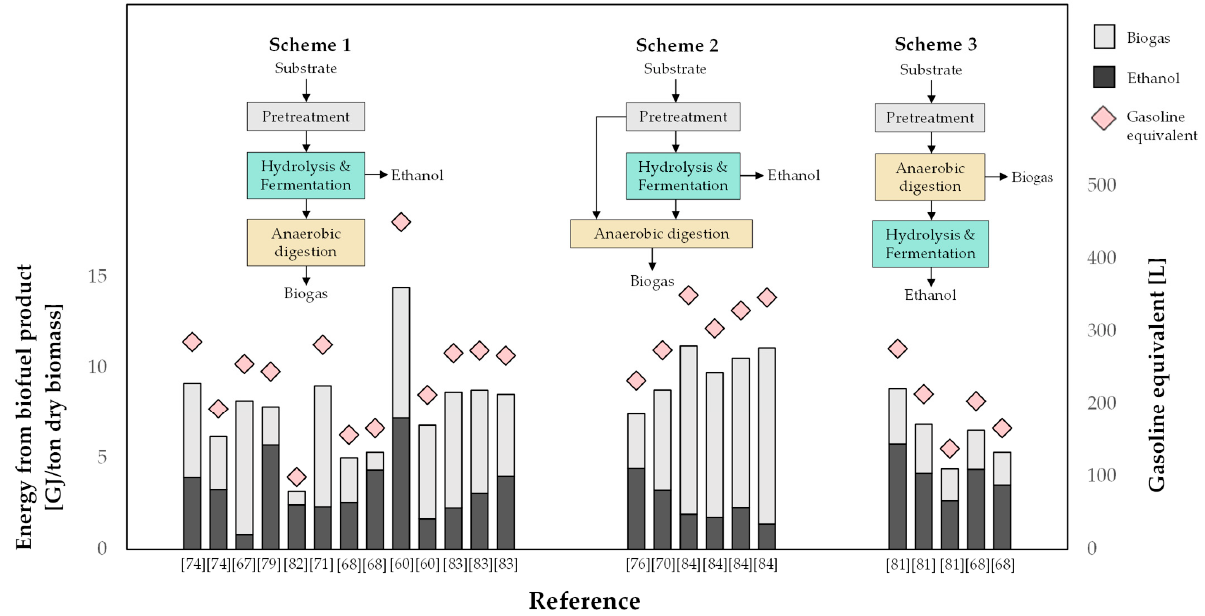
Figure 2. Gross energy output from studies on co-production of bioethanol and biogas from 2G